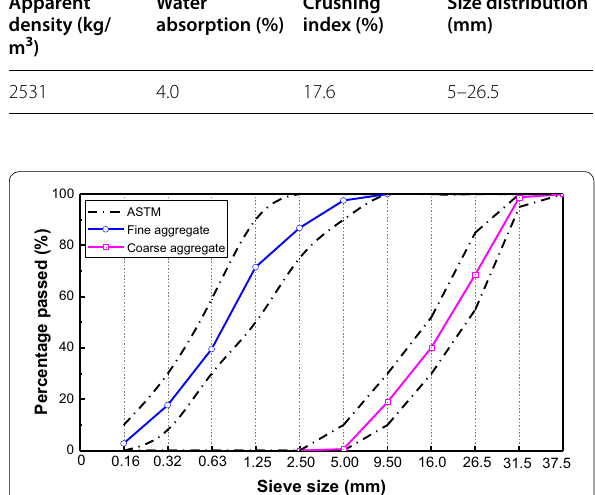
Table 2 Physical properties of recycled coarse aggregate. Apparent density (kg/